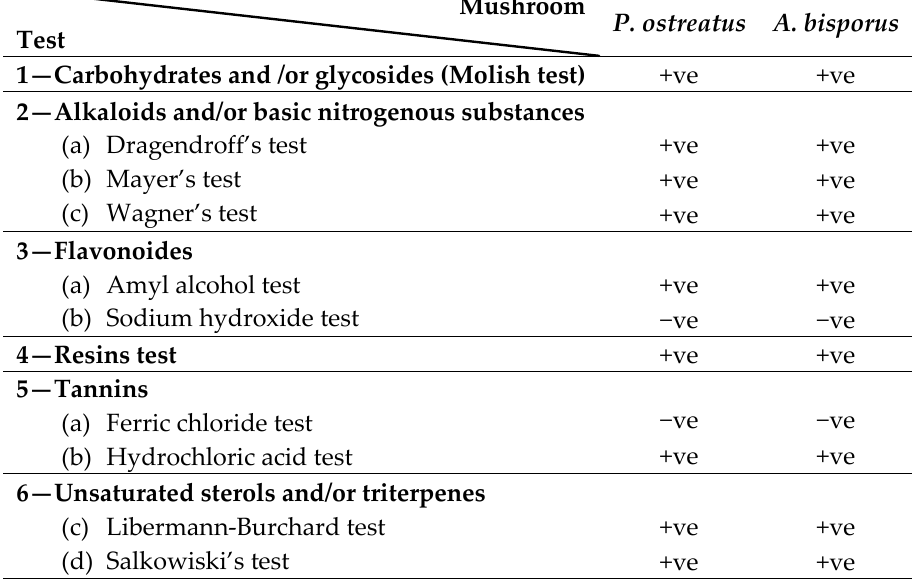
Table 1. Preliminary phytochemical screening of A. bisporus and P. ostreatus .